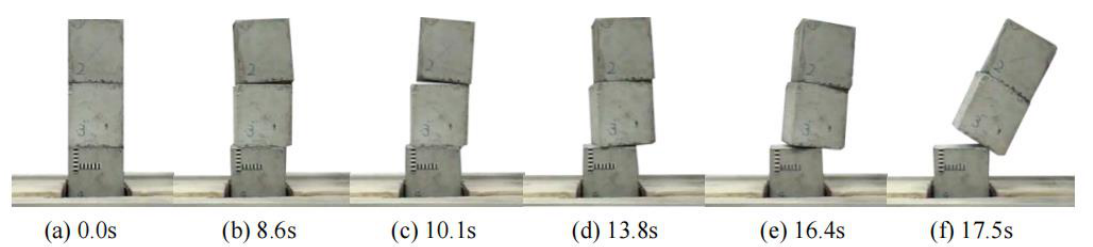
Figure 18. Behavior of the blocks under the shaking table